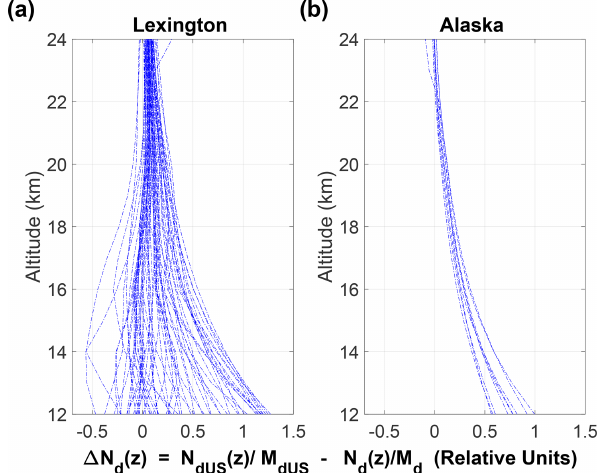
Figure 3. Differences between the number molecular density, N d ( z ), from soundings and from the 1962 US Standard Atmosphere in the region from 12 to 24km. Panel (a) represents N d ( z ) from Nantucket soundings used for Lexington and (b) N d ( z ) from Fair- banks.